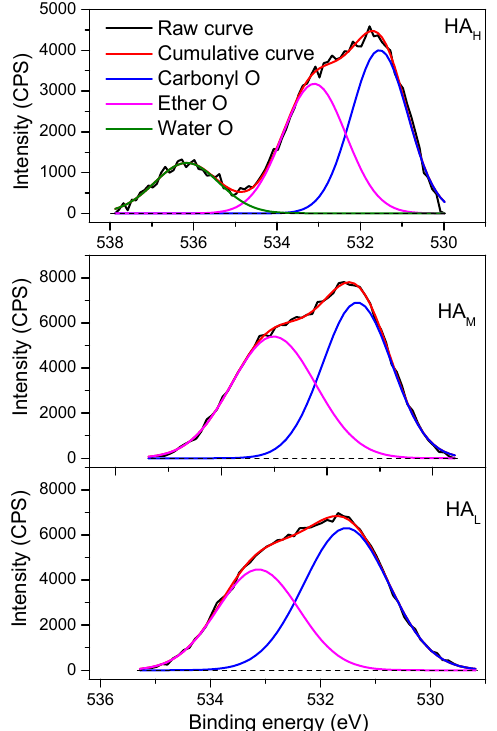
Figure 5. High-resolution O 1 s X-ray photoelectron spectra of HA fractions. The black dash line means the baseline of each sample.